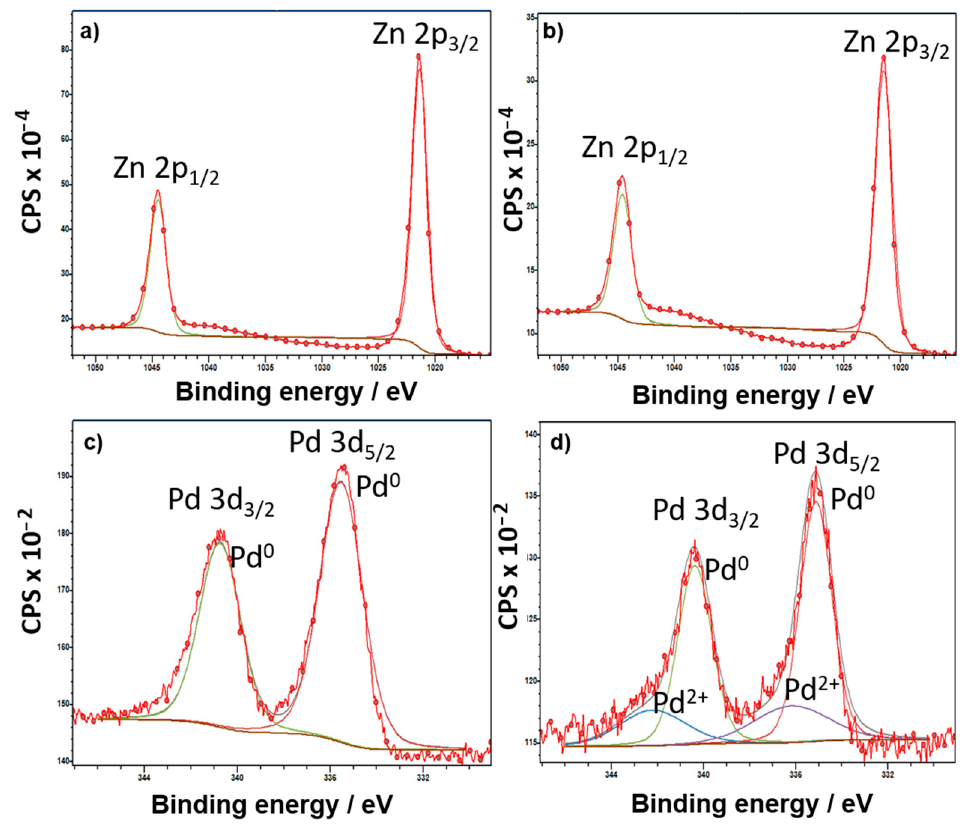
Figure 5. Zn 2p spectrum of Sample B ( a ) before and ( b ) after irradiation; Pd 3d spectrum of Sample B ( c ) before and ( d ) after irradiation.